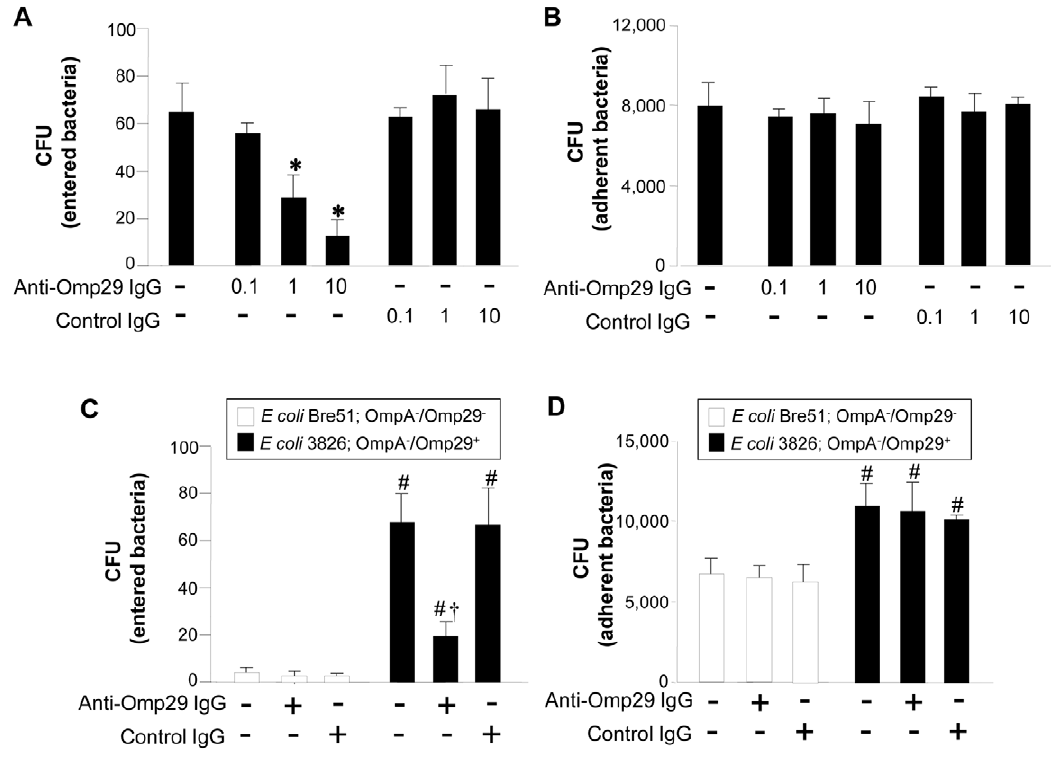
Figure 3. Anti-Omp29 IgG antibody inhibits bacterial entry, but not adhesion, to OBA9. Live Aa Y4, Omp29 2 /OmpA 2 E. coli strain Bre51 or Omp29 + /OmpA 2 E. coli strain 3826 harvested at the mid-log phase was incubated with confluent OBA9 in a 96-well plate (5.5 6 10 5 bacteria/100 m l/ well) in the presence of anti-Omp29 IgG antibody or control serum IgG. For E. coli strains, a dose of anti-Omp29 serum IgG (10 m g/ml) or control serum IgG (10 m g/ml) was applied to each well. After 4 hours of incubation, entry (A) or adhesion (B) of Aa Y4, or entry (C) or adhesion (D) of Omp29 2 /OmpA 2 E. coli strain Bre51 or Omp29 + /OmpA 2 E. coli strain 3826 to OBA9 was measured. Each column represents mean CFU 6 SD of three wells. One representative result from at least 3 different experiments is shown. *, Significantly lower than Aa Y4 incubated in medium alone (without antibody) or control IgG by Student’s t test ( P , 0.05). # , Significantly higher than E. coli Bre51 entry or adhesion to OBA9 in the absence of antibody by Student t test ( P , 0.05). { , Significantly lower than the entry of E. coli 3826 incubated in medium alone (without antibody) or control IgG by Student t test ( P , 0.05).